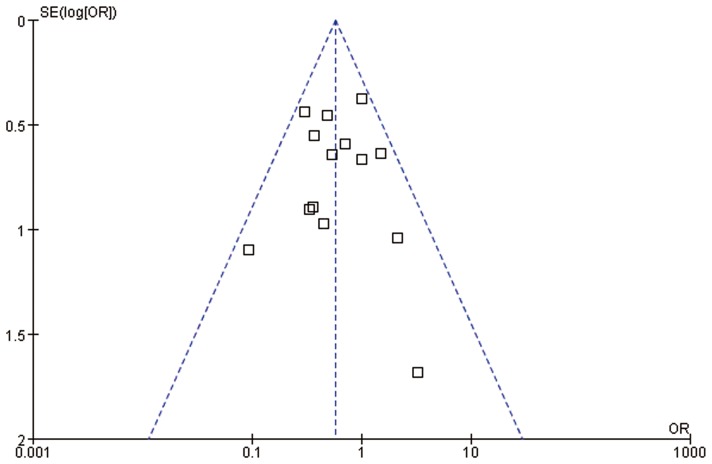
Funnel plot of morbidity in all included studies.